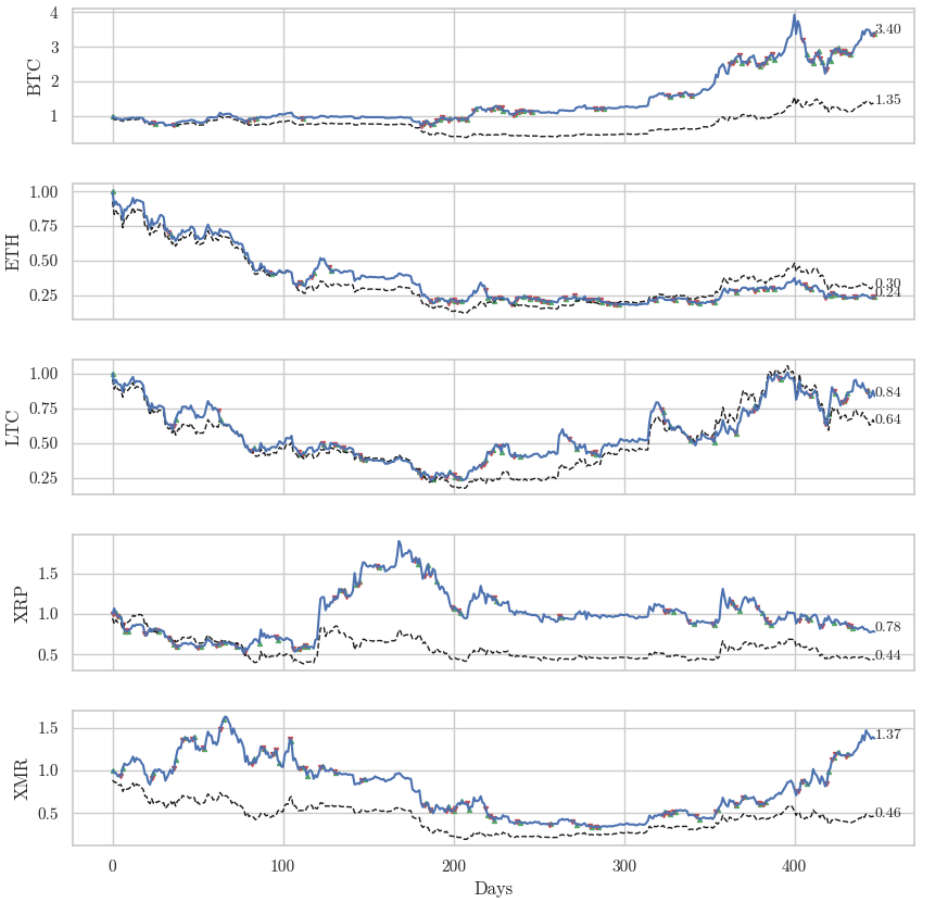
Figure 1. This figure shows the beginning value (1 unit of cryptocurrency) and cumulative ending value using a buy-and-hold approach (dotted black line) and our direct reinforcement model (blue line). The green and red dots in our direct reinforcement model correspond to a long or short position,